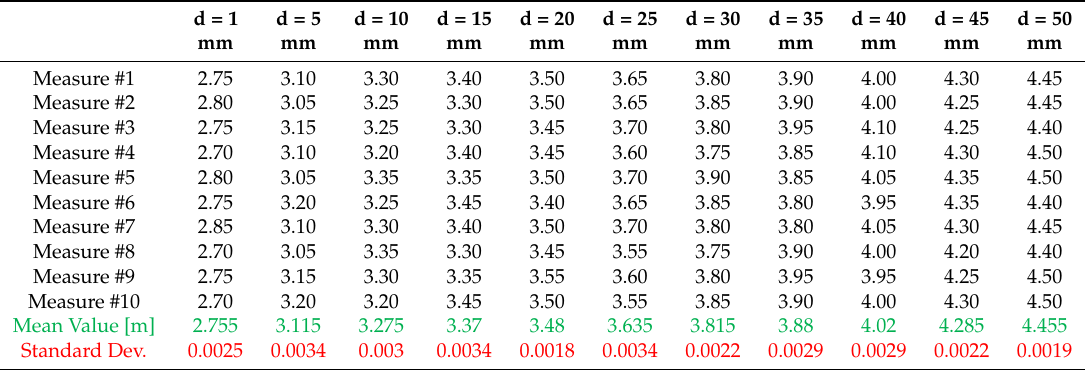
Table 1. Measured read range of the antenna under test for 10 different measure campaigns. For each antenna distance from the body phantom, the mean value (in green) and the standard deviation (in red) are